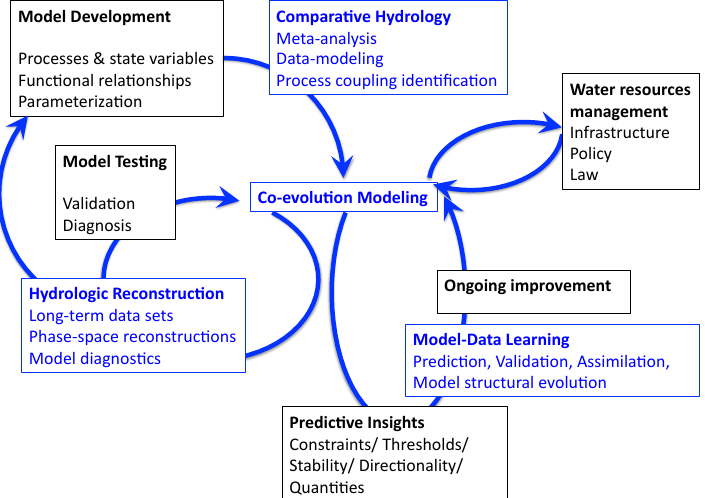
Fig. 2. Components of the proposed research agenda to develop predictive insight over 100yr time frames in non-stationary water